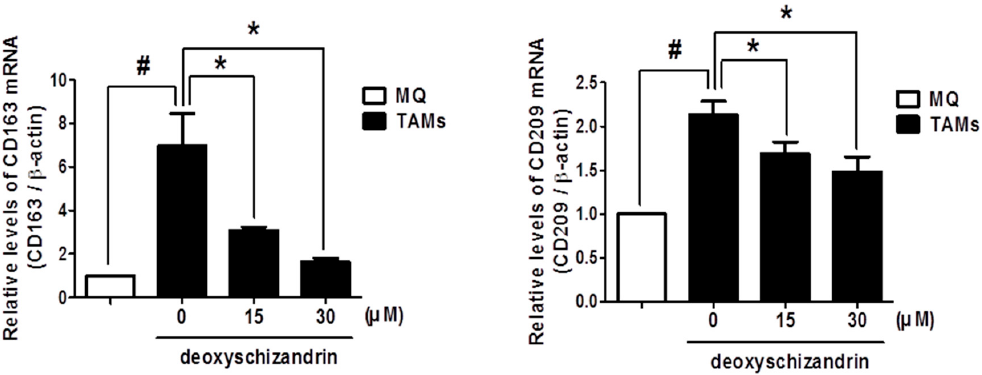
Figure 6. Effect of deoxyschizandrin on the expression of CD163 and CD209 in tumour-associated macrophages (TAMs); THP-1 cells were stimulated with conditioned medium from A2780 cells and were treated with the indicated concentration of deoxyschizandrin (15 and 30 µM) for 48 h. Real-time RT-PCR was conducted to measure the mRNA levels of CD163 and CD209 in macrophages. The values represent the mean ± SD of results from three independent experiments. # p < 0.05 vs. MQ; * p < 0.05 vs. the untreated TAMs.